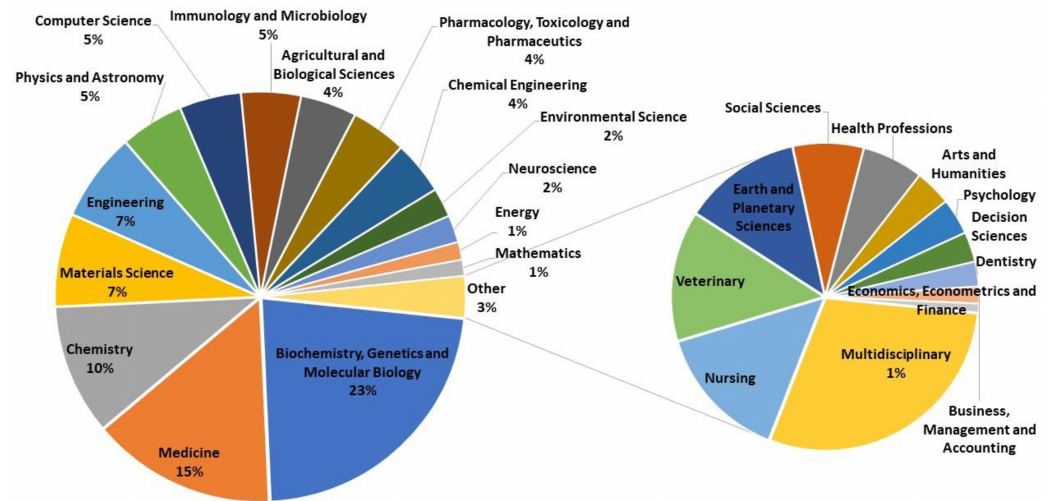
Figure 7. Distribution of the scientific output by ASJC (articles, books, and proceedings).